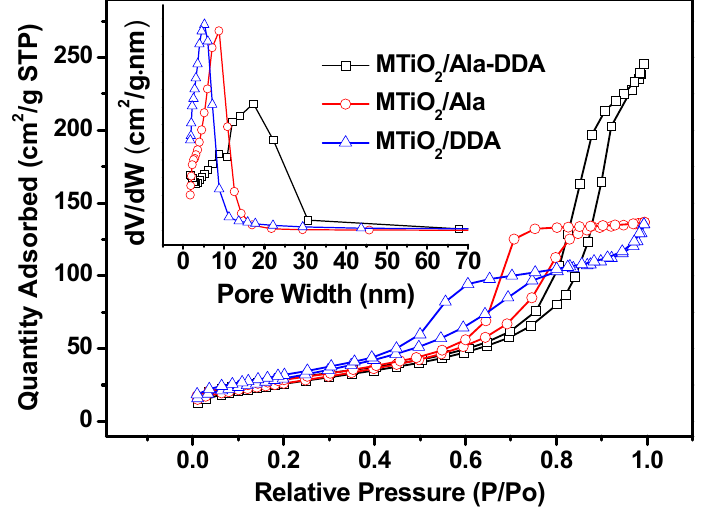
Figure 2. N 2 -sorption isotherms and pore size distribution curves (inset) of as-prepared samples.